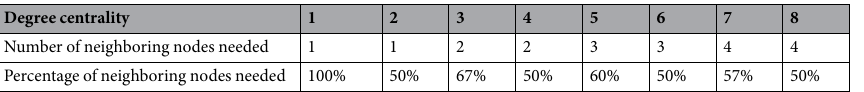
Table 3. Number of neighboring nodes required for a local